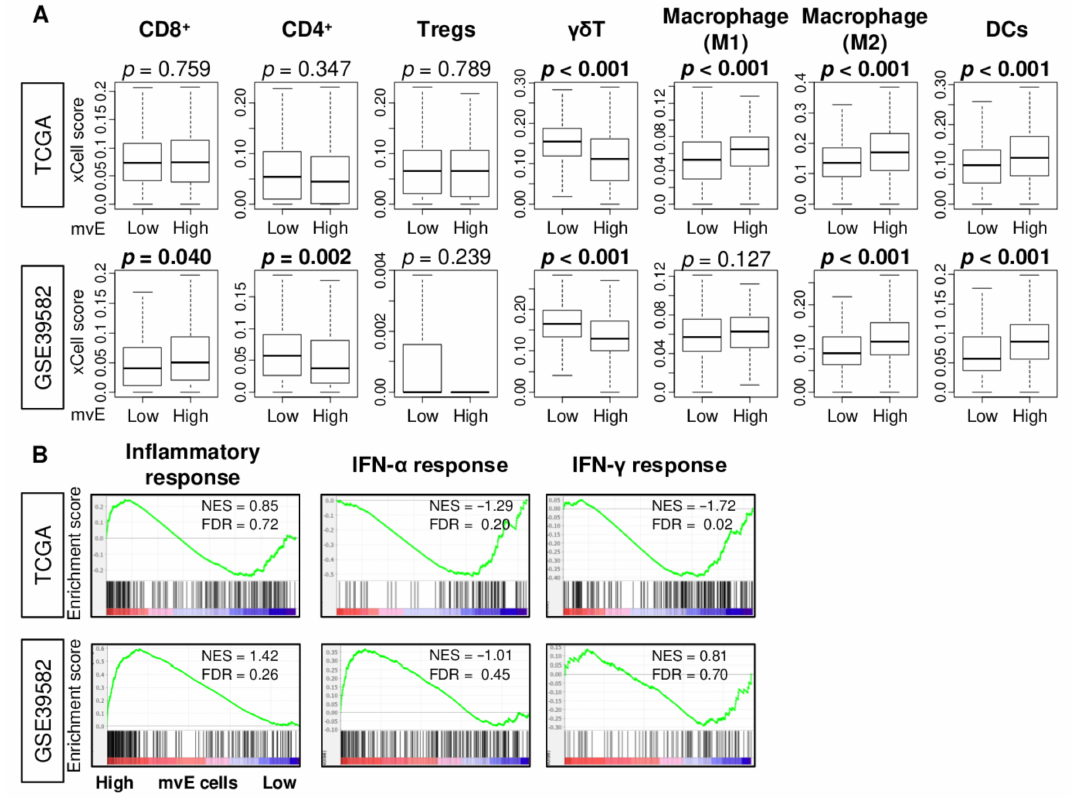
Figure 4. Association between amount of mvE cells and immunity of TME in the TCGA and GSE39582 cohorts. ( A ) Boxplots of the fraction of immune cells; CD8 + T cells, CD4 + T cells, M1 and M2 macrophages, dendritic cells (DC), γδ T cells, and regulatory T cells (Tregs) by high and low mvE cell tumor groups in both cohorts. p -value was calculated by the Mann–Whitney U test. ( B ) Enrichment plots of immune-related gene sets; inflammatory response and interferon (IFN)- α and - γ response in both cohorts. The top one-fourth was used as a cut-off to divide low and high groups for each cohort. NES; normalized enrichment score; FDR, false discovery